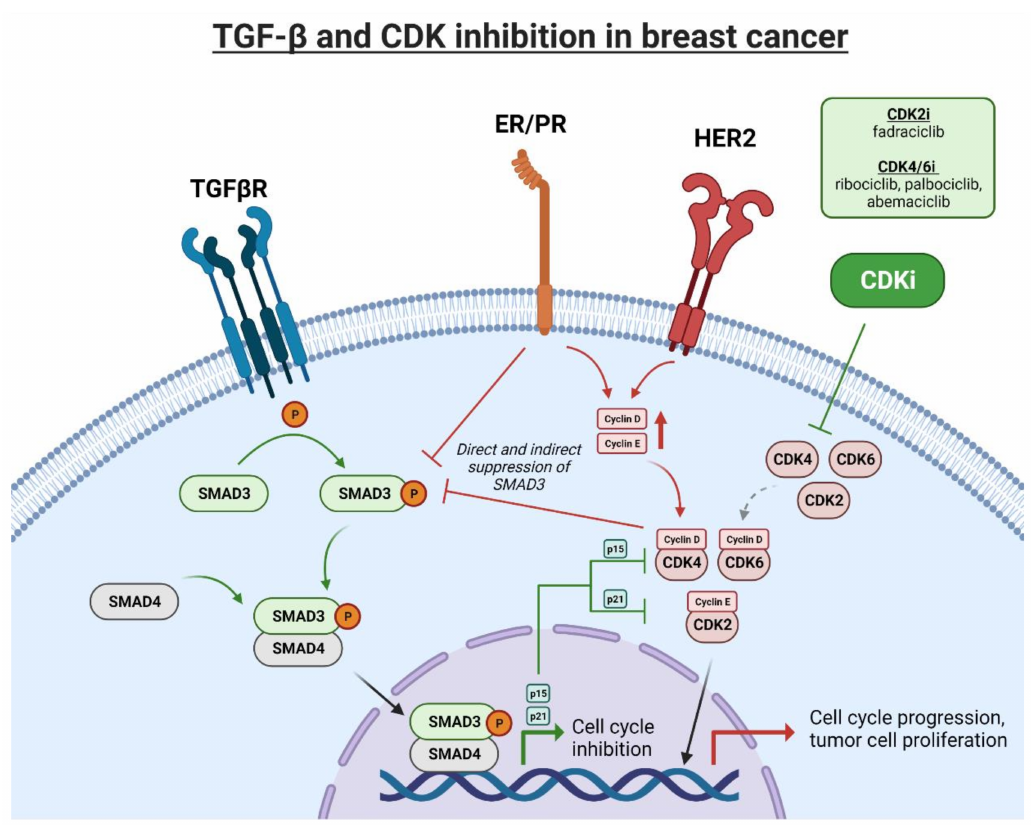
Figure 2. Interconnected signaling pathways between oncogenic activation of CDKs and TGF β . Image generated using